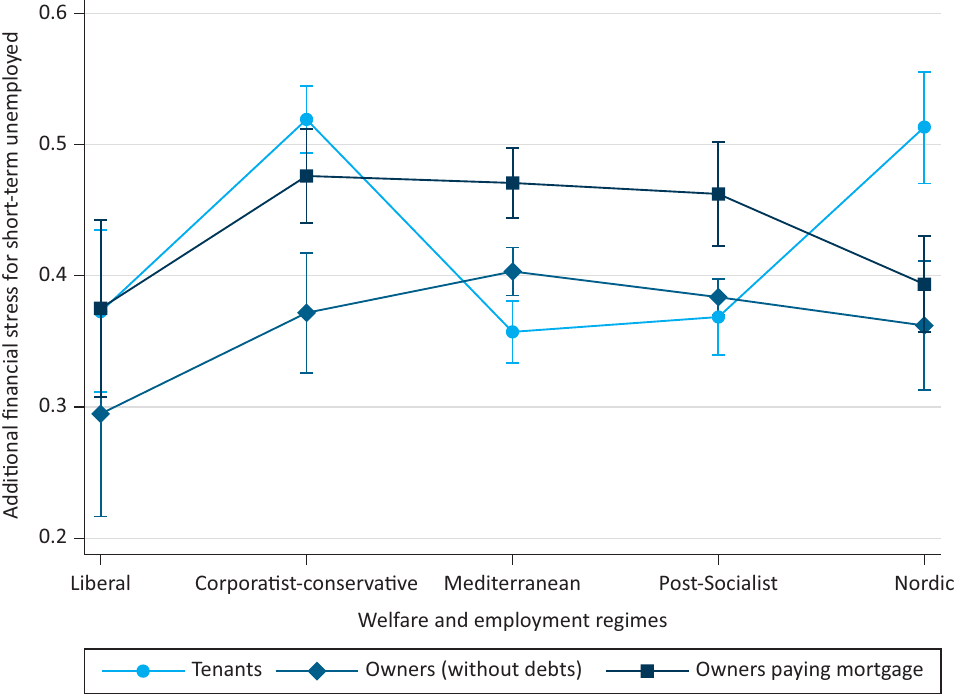
Figure 3. The additional financial stress of short‐term unemployment (for 2010–2018, 27 countries, 95% confidence inter‐ val). Notes: N = 1,503,456 people aged 25 to 64 years; plot of the average marginal effects of a three‐way interaction (regime*tenure status*short‐term unemployment) in a linear multi‐level regression on subjective financial stress; no indi‐ vidual or national control variables are considered. Source: Based on Eurostat